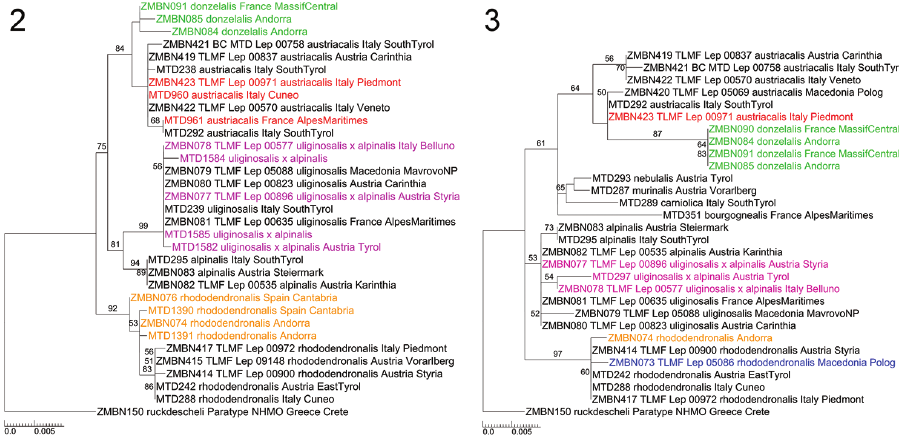
Figures 2–3. Maximum Likelihood analysis of EF1a ( 2 ) and wingless ( 3 ) data of the Udea alpinalis species group. Numbers on branches represent bootstrap values of ≥ 50% inferred from 1,000 replicates. Note that the taxon set is not identical for the two analyses, scale bars represent substitutions per